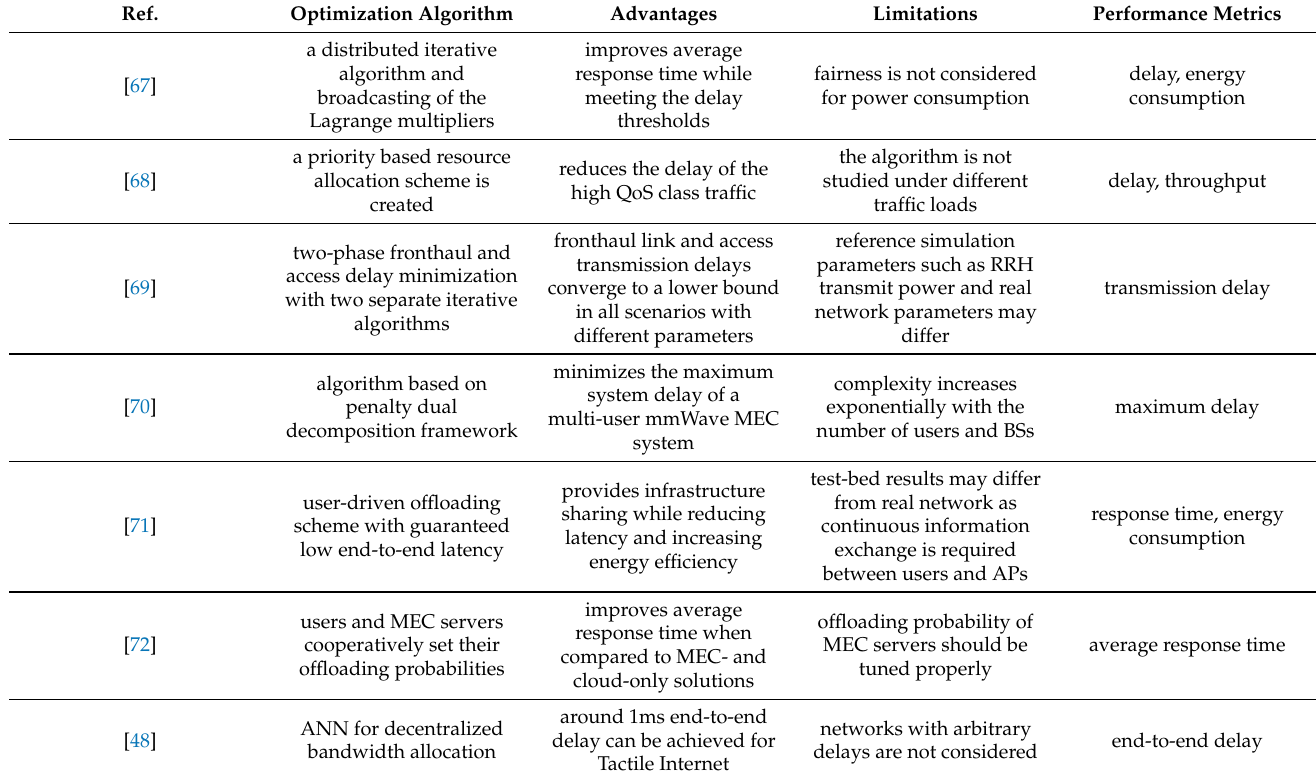
Table 4. Analysis of resource allocation papers with delay minimization objective.